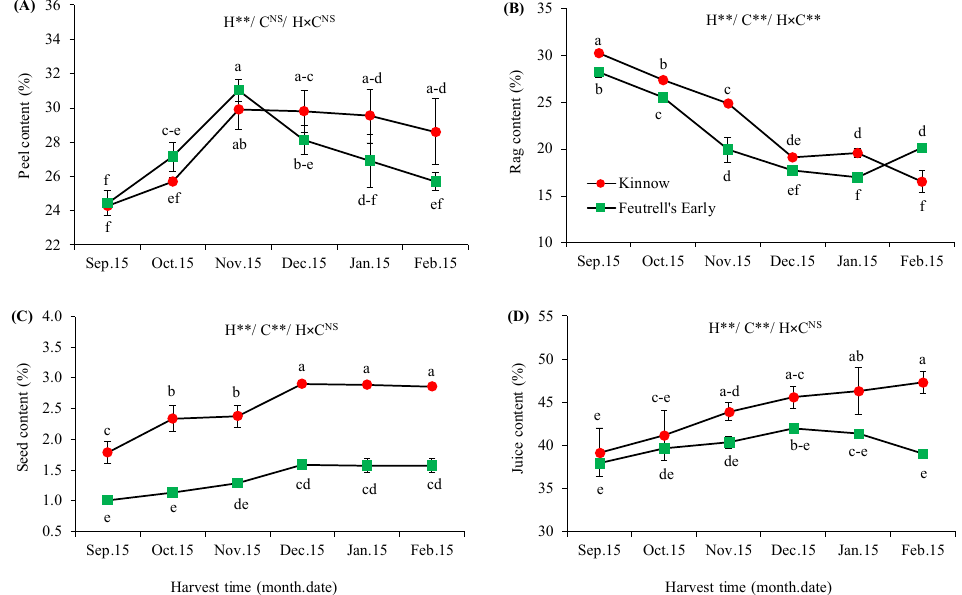
Figure 3. Changes in peel ( A ), rag ( B ), seed ( C ), and juice ( D ) content of mandarin fruits (Kinnow and Feutrell’s Early) at different harvest times. Error bars show standard errors of the means ( n = 4). Different lowercase letters in each graph indicate significant differences at p < 0.05 between tested samples at different stages by the least significant difference test. H and C stand for harvest time and cultivar, respectively. H × C presents the effect of the interaction of harvest time and cultivar. NS, non-significant; significant at ** p < 0.01.